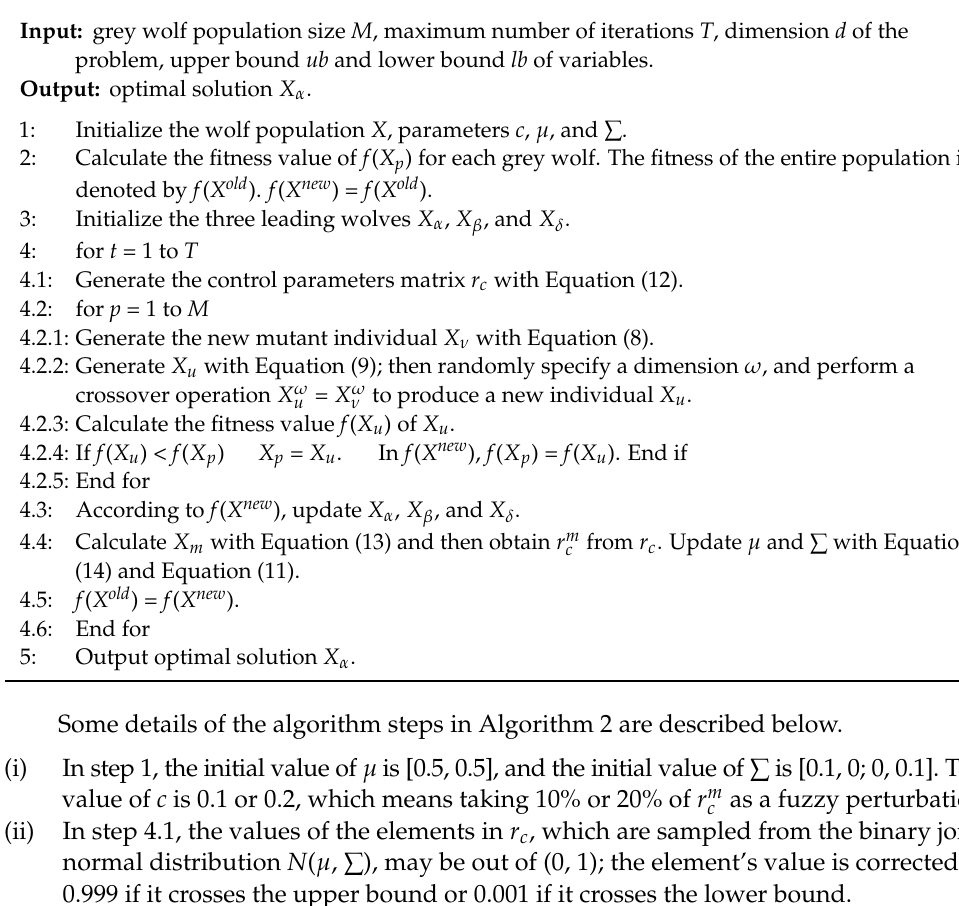
Algorithm 2. Steps of the FSGWO